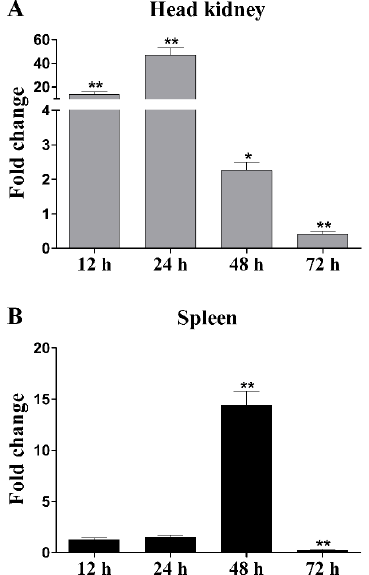
Figure 5. Expression analysis of LycCTLR gene in head kidney ( A ) and spleen ( B ) after inactivated trivalent bacterial vaccine induction. Head kidney and spleen were collected at 0, 12, 24, 48, and 72 h after bacterial vaccine induction, and total RNA was extracted for real-time PCR analysis. The relative expression level of LycCTLR was normalized by that of β -actin. The fold change was calculated as the average expression level of LycCTLR in the bacterial vaccine-challenged samples divided by that in the samples from phosphate buffered saline (PBS)-injected fish at each time point. Each experiment was performed in triplicate; error bars represent the standard error of the mean (SEM). The statistical significance of differences in gene expression was generated by two-tailed Student’s t -test compared with the data from PBS-injected group ( * p < 0.05; ** p < 0.01).